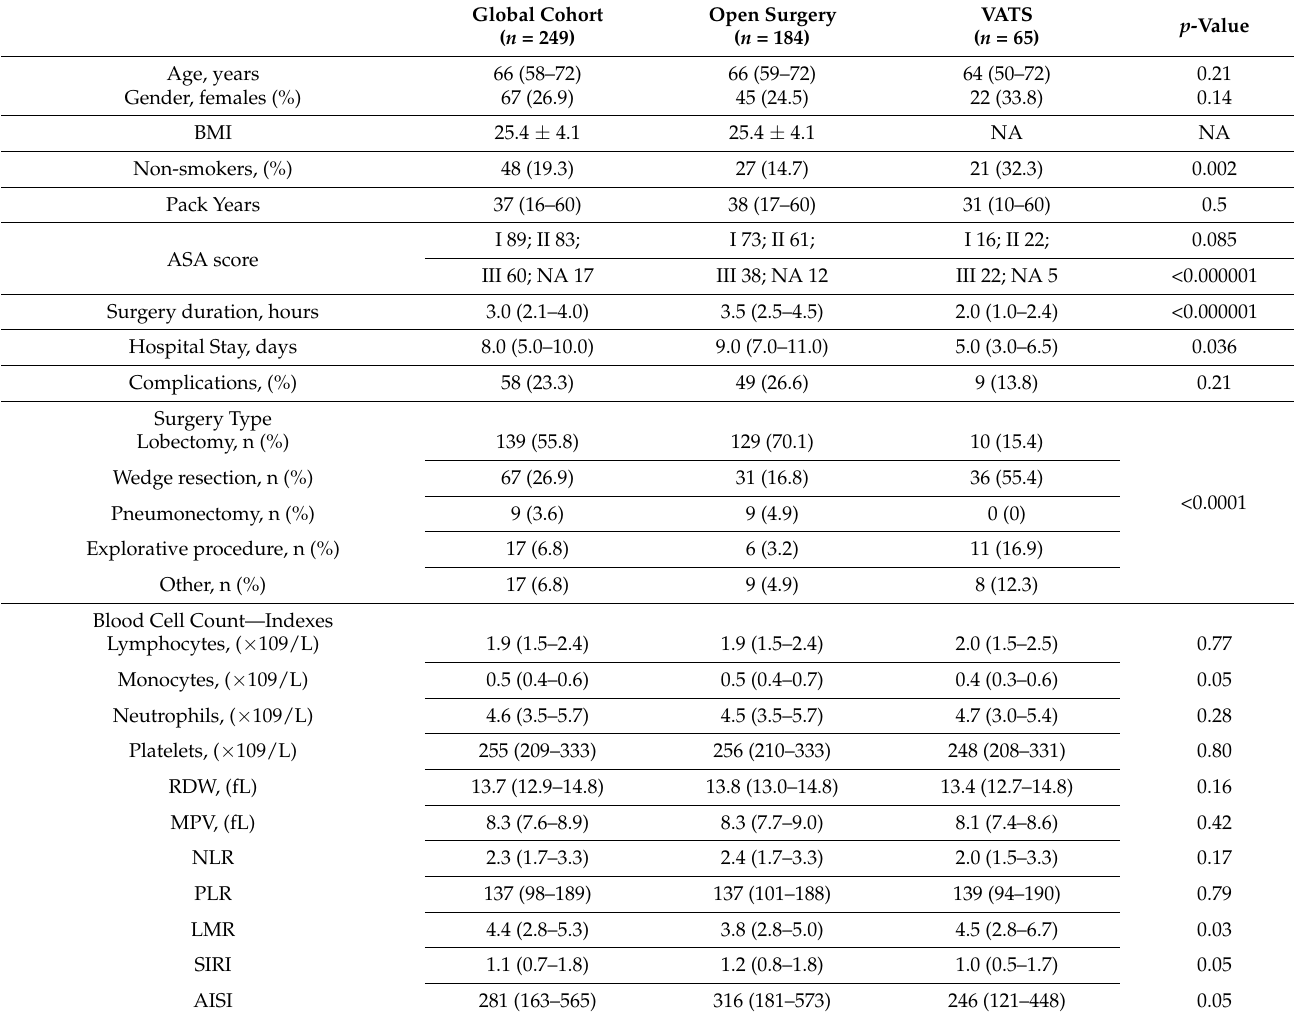
Table 1. Main demographic, clinical and basal laboratory features of the patients included in the